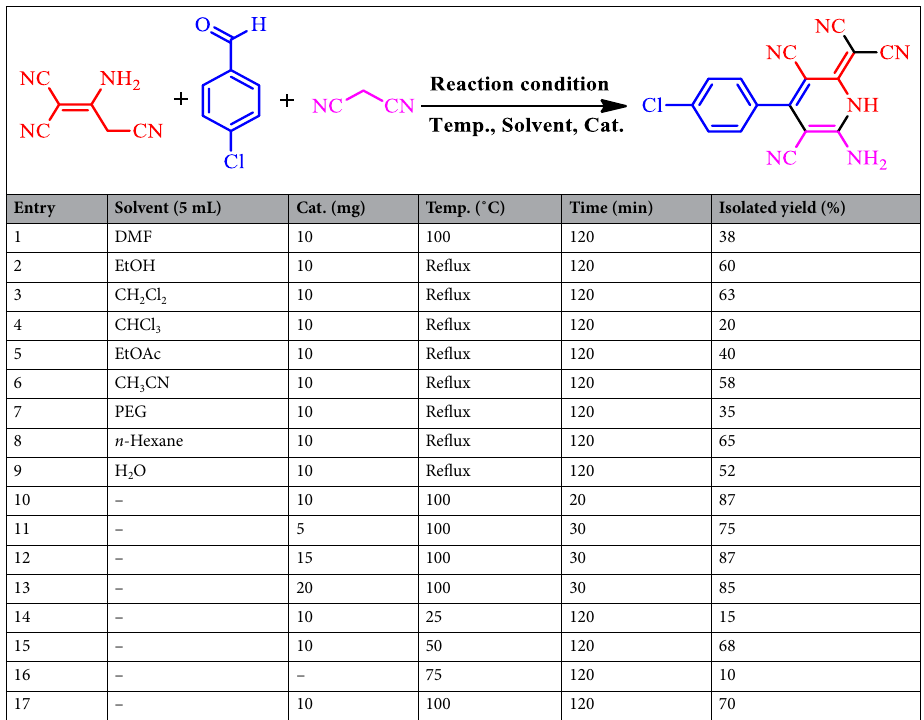
Table 1. Effect of different amounts of catalyst, temperature and solvent (5.0 mL) in the synthesis dicyanomethylene